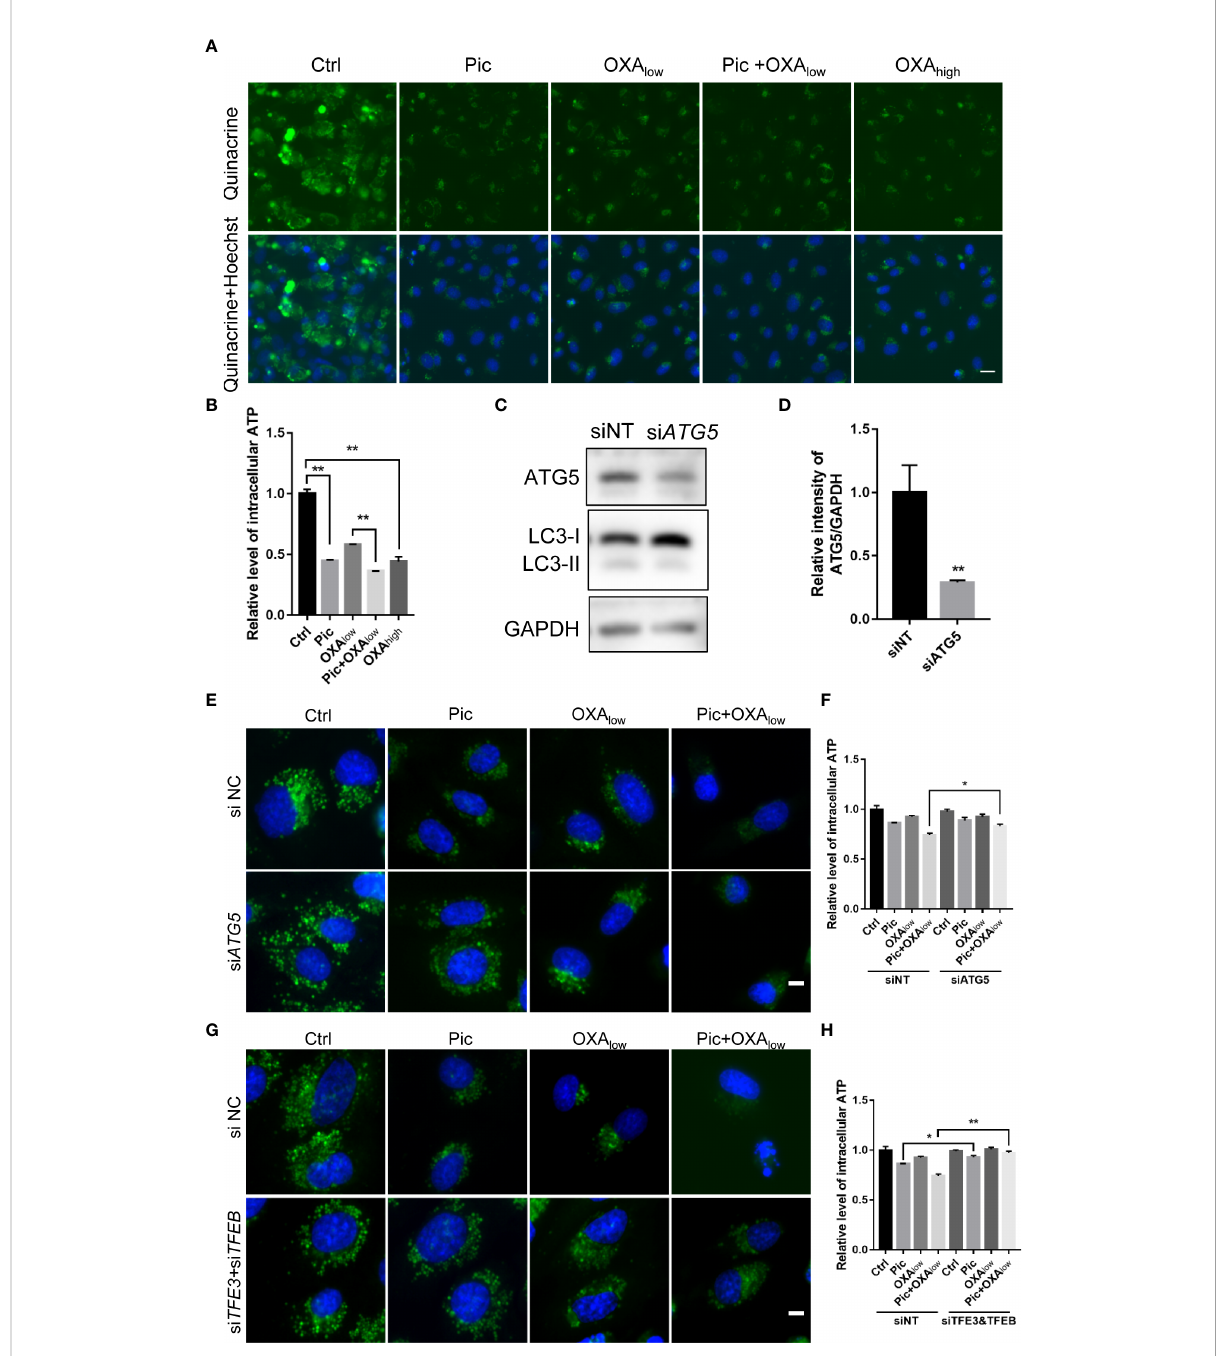
FIGURE 3 Piceatannol enhances ICD inducer OXA-induced ATP release via TFEB/TFE3-mediated autophagy. (A, B) Pic (40 m M) in combination with a low concentration of the ICD inducer oxaliplatin (OXA low , 200 m M) reduces intracellular ATP levels in U2OS cells. ATP was measured by quinacrine staining in cells treated with Ctrl, Pic, OXA low , OXA low +Pic and a higher concentration of OXA (OXA high , 400 m M), which was used as a positive control (A) . Scale bar: 20 m m. The intracellular ATP levels was quanti fi ed in (B) . (C – F) Pic (40 m M) plus OXA low -induced ATP release is comprised after knocking down the expression of an autophagy essential gene, ATG5. U2OS cells were transfected with ATG5 speci fi c siRNA for 48 h before western blotting analysis of the levels of ATG5 and LC3-II (C) , the ratio of the relative intensity of ATG5 over that of GAPDH was quanti fi ed (D) . 48 h post si-ATG5 transfection, cells were treated with Pic (40 m m), OXA low and OXA low +Pic for another 24h. The intracellular ATP levels were detected by quinacrine staining as in (A, E) , and the relative ATP level was quanti fi ed in (F) . Scale bar: 10 m m. (G, H) Pic (40 m M) plus OXA low -induced ATP release is compromised after knocking down the expression of TFEB and TFE3. The intracellular ATP levels were detected by quinacrine staining as in (A, G) , and the relative ATP level was quanti fi ed in (H) . Data were means ± SEM from at least three replicates. Student-t test was used for statistical analysis. * p -value < 0.05 and ** p -value <